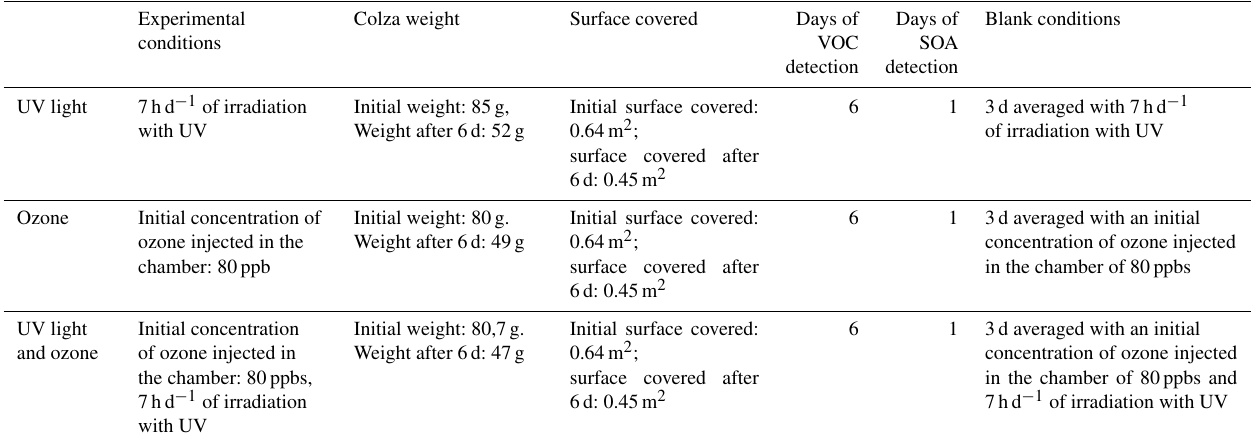
Table 1. Experimental conditions. Experimental Colza